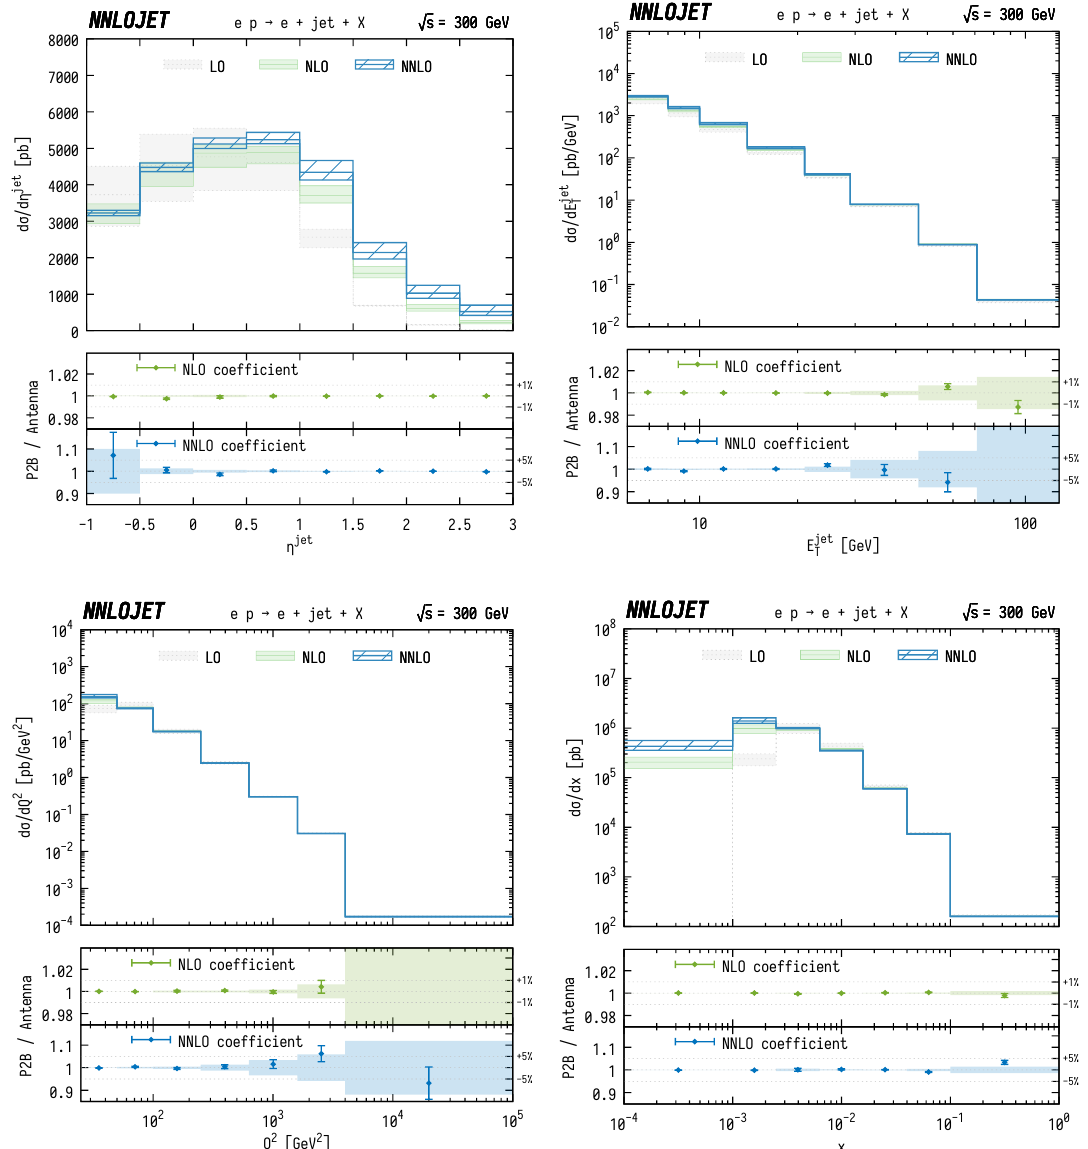
Figure 1 . Comparison of results up to NNLO obtained with the P2B and the antenna subtraction methods. The upper frames in each plot show the absolute predictions obtained using the P2B method. The lower frames display the ratio of the predictions obtained in the P2B and antenna subtraction computations for the NLO-only and NNLO-only contributions to the di(cid:11)erential cross sections, with error bars and (cid:12)lled areas representing numerical integration errors of the P2B and antenna-subtraction results, respectively. The cuts and jet de(cid:12)nition are as in eqs. (4.1) and